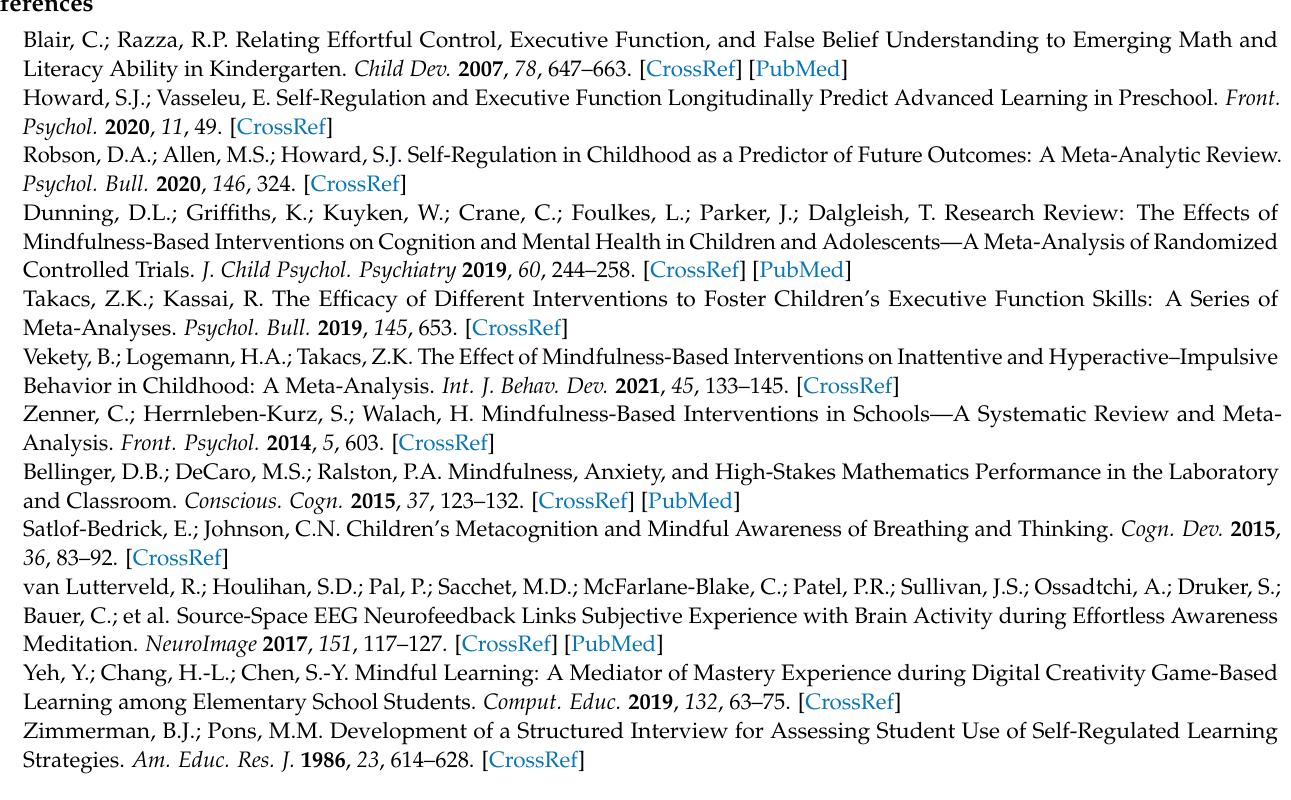
Table S1: The content and protocol of the mindfulness program with the Muse brain-sensing device for school-aged children, Table S2: Significant statistical outliers and missing data in the statistical models, Table S3: Results of the ANOVAs on EFs and brain activity in statistical model